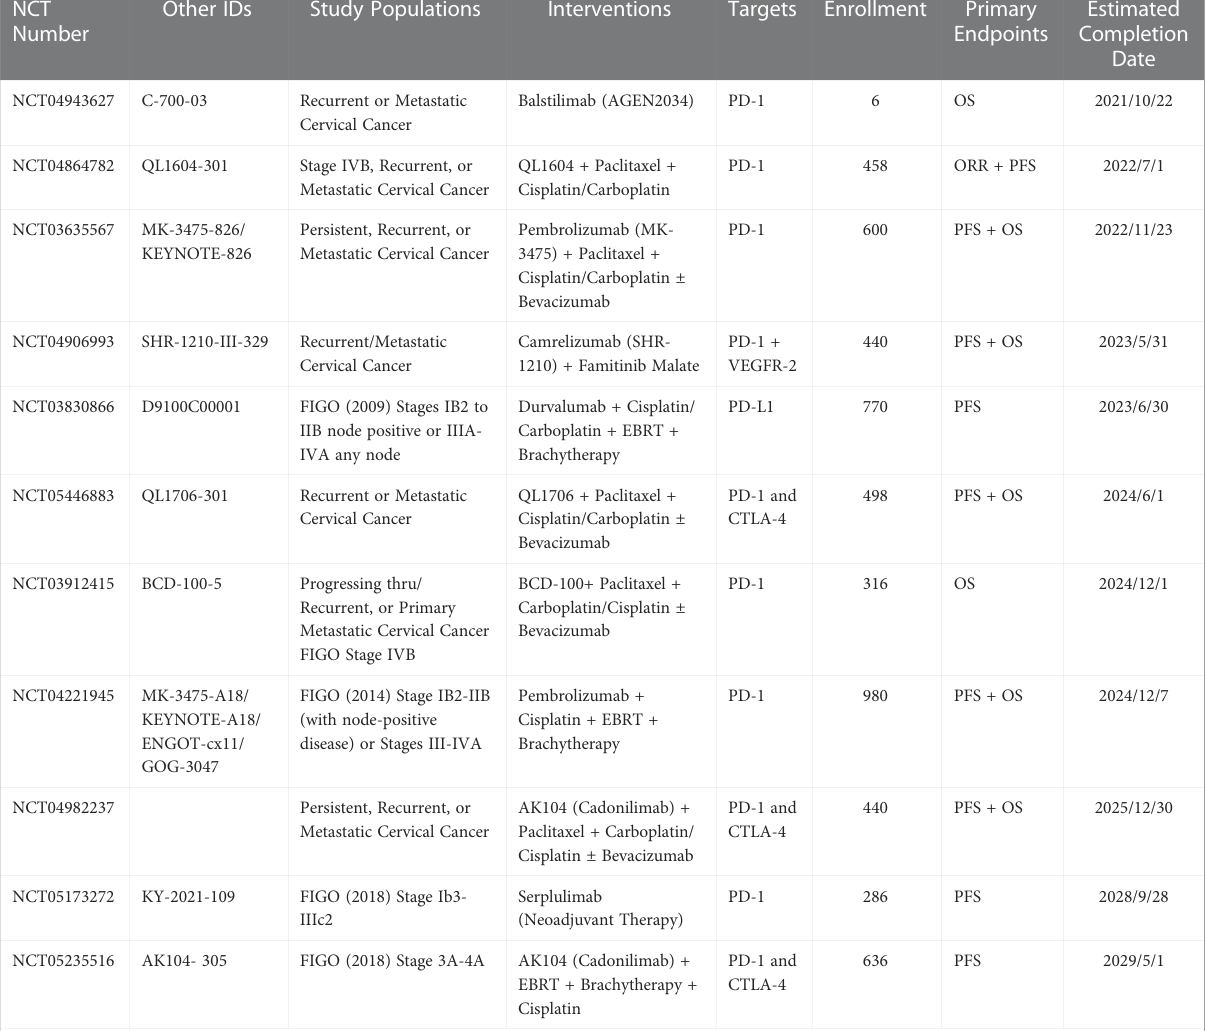
TABLE 1 Phase III clinical trial of immune checkpoint drugs for locally advanced or recurrent/metastatic cervical cancer (derived from clinicaltrials.gov, accessed 12 Sep 2022). NCT Number